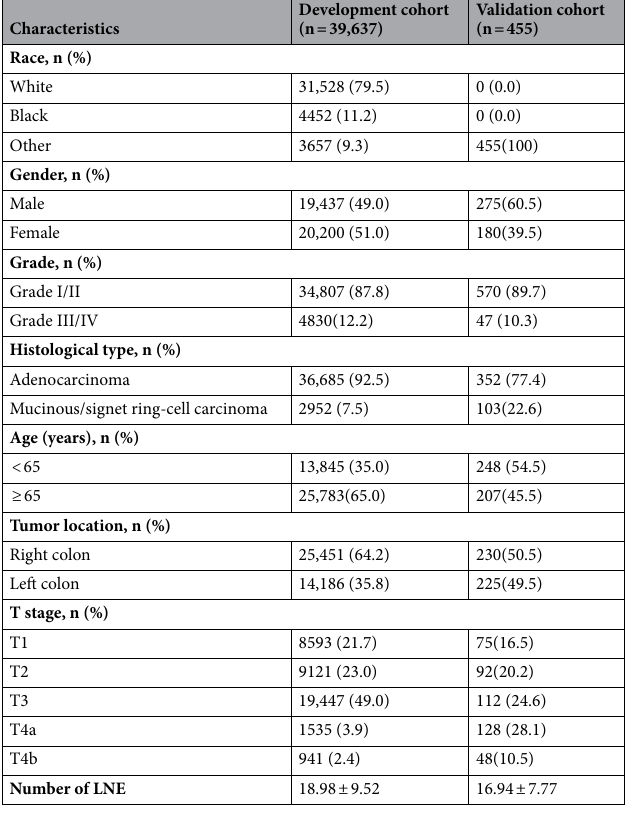
Table 1. Characteristics of patients in the development and validation